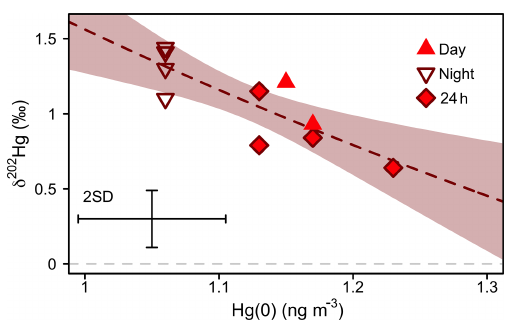
Figure 6. Mass-dependent Hg isotope signature ( δ 202 Hg) of at- mospheric Hg(0) versus Hg(0) concentration during the snow-free growing period (11 June–10 September 2016). The dashed line rep- resents a non-linear Rayleigh fit and the shaded area is the 95% confidence interval (see main text). Error bars represent the analyt- ical precision determined by the 2SD from multiple measurements of an in-house standard.